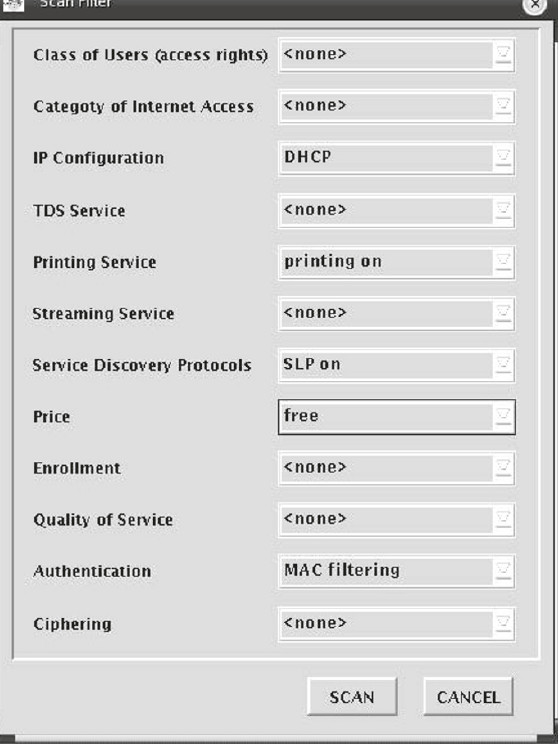
of the MT dynamically acquired via DHCP. In other words, when a user decides to attach to the AP supporting the TDS service, then the TWS automatically retrieves the entire set of information needed to configure the service, and performs service